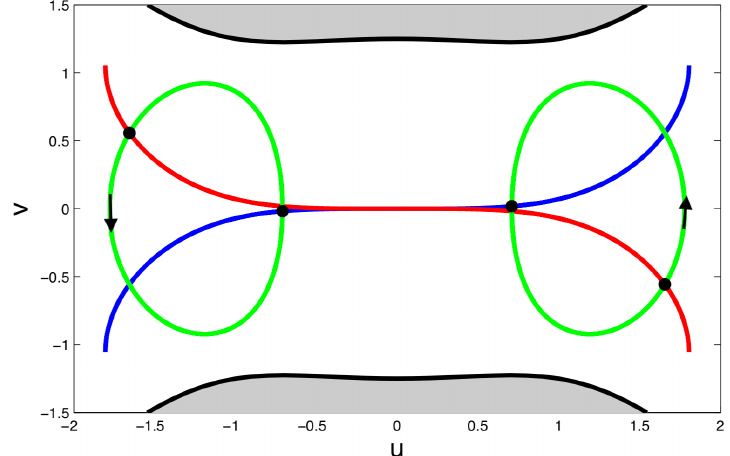
Figure 6. Symmetric unstable periodic orbits are shown in green. Two pairs of black dots mark the intersections of the periodic orbit with the SOS. The thick black line represents the boundary between the energetically allowed (white) and forbidden (shaded)